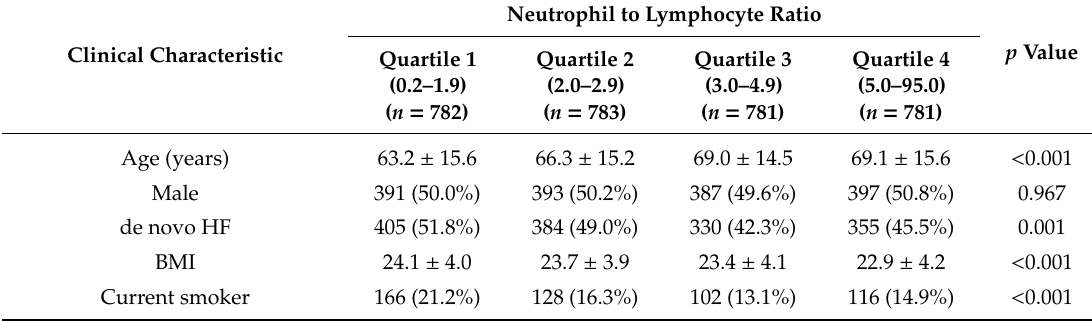
Clinical Characteristic